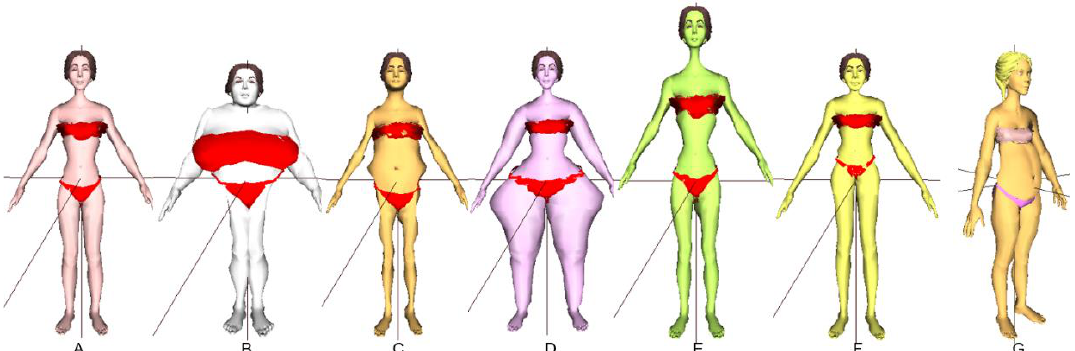
Figure 3. Seven avatars with accessories (eyes, eyes brows, hair, cloths): ( A ) thin, ( B ) big breast, ( C ) big waist, ( D ) big hip, ( E ) tall avatar, ( F ) long legs and ( G ) pregnant thin avatar. (Avatar ( G) has different view/pose as we would like to em- phasize that this avatar has been added to this study while other avatars are from our previous study. Avatars ( A )-( F ) are shown in ‘front view’. However, if avatar ( G ) is shown in only ‘front view’, the shape changes from pregnancy would be difficult to notice.).